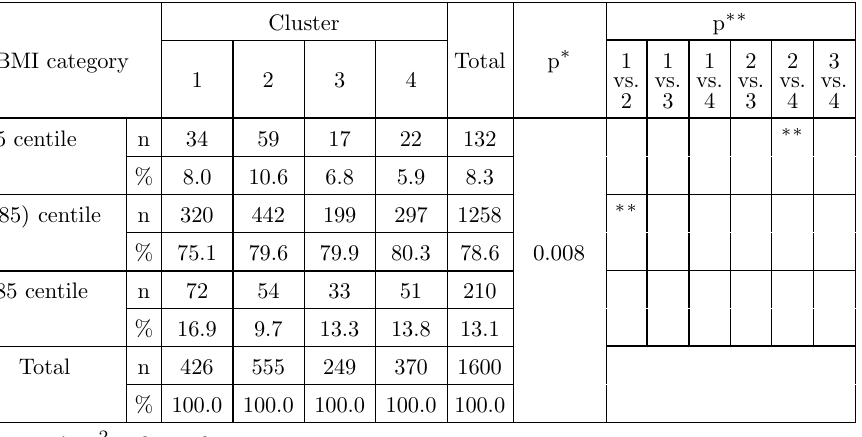
Table 4. Sex of surveyed students in separate clusters Cluster p ∗∗ Sex Total p ∗ 1 1 1 2 3 4 vs. vs. vs. vs. vs. vs. 2 4 Boys n 113 104 109 567 ∗∗ ∗∗ ∗∗ ∗∗ % 26.5 Girls n 313 314 145 261 1033 < 0 . 001 ∗∗ ∗∗ ∗∗ ∗∗ % 73.5